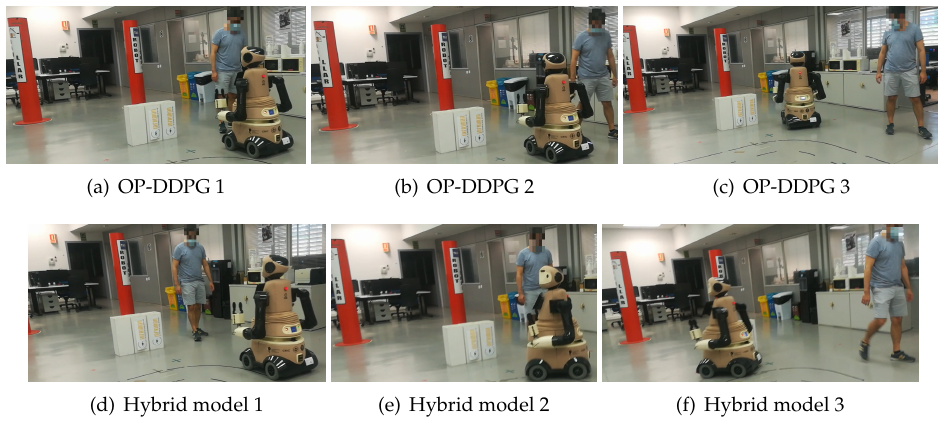
Figure 8. Experiment with a person. From 1 to 3 shows the robot behavior when the robot uses the OP-DDPG model and the hybrid model. In the first case, the person has to adapt to the robot motion, while, in the second case, it is the robot who adapts to the person.